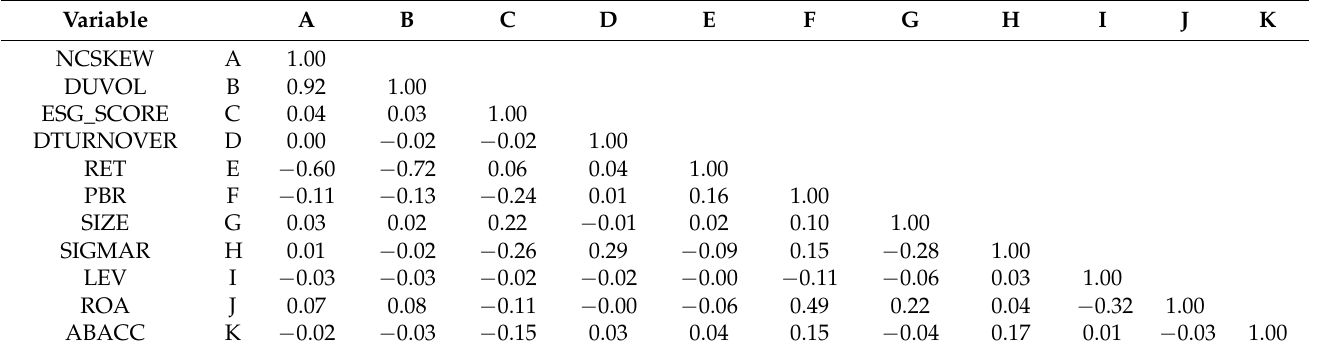
Table A3. Correlation Matrix for Nikkei-225